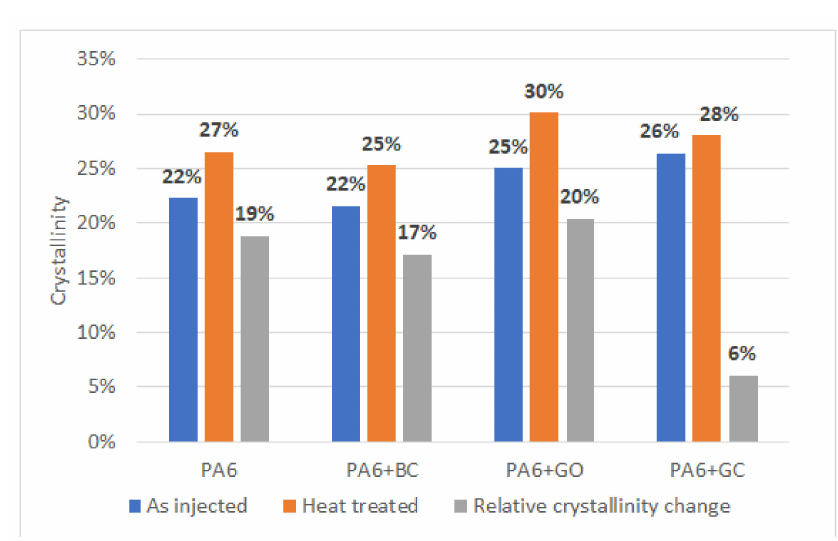
Figure 8. Comparison of crystallinity results obtained using